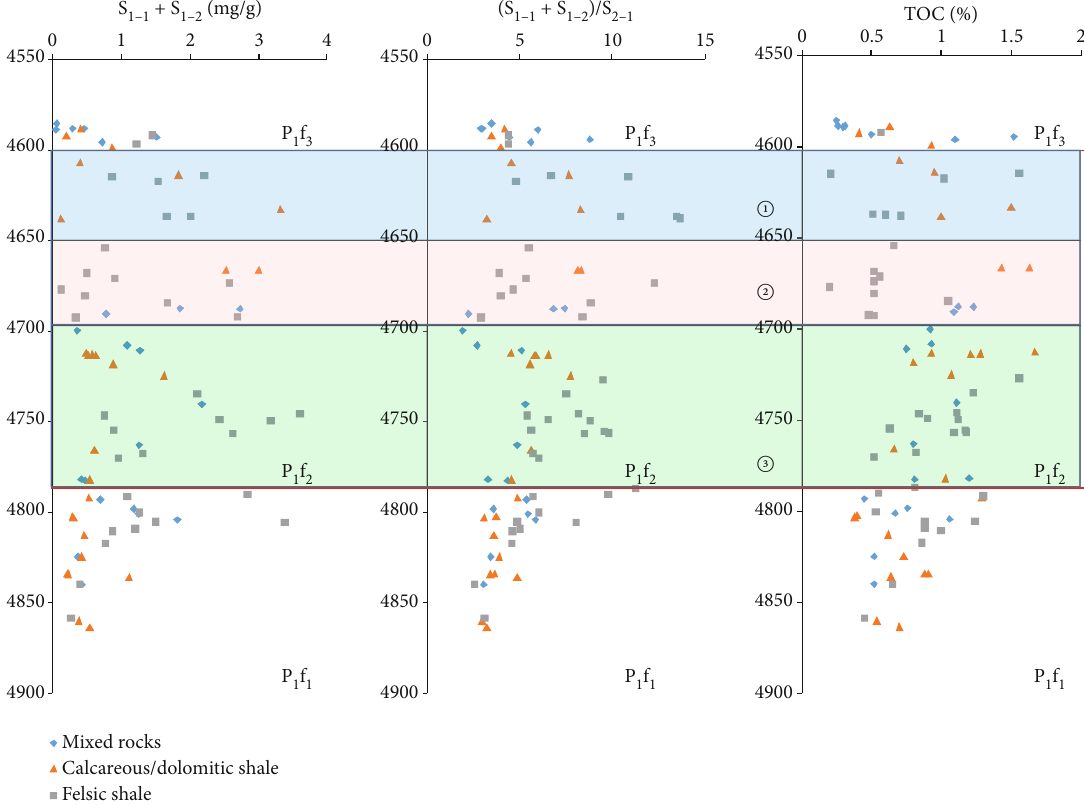
Figure 16: Shale oil mobility in di ff erent lithofacies in the Fengcheng Formation. (1) Interbedded development of lime/dolomitic shale facies and felsic shale facies; (2) continuous development of felsic shale facies intercalated with thin layers of lime/dolomitic shale facies; (3) continuous development of hybrid sedimentary rock facies, lime/dolomitic shale facies, and felsic shale